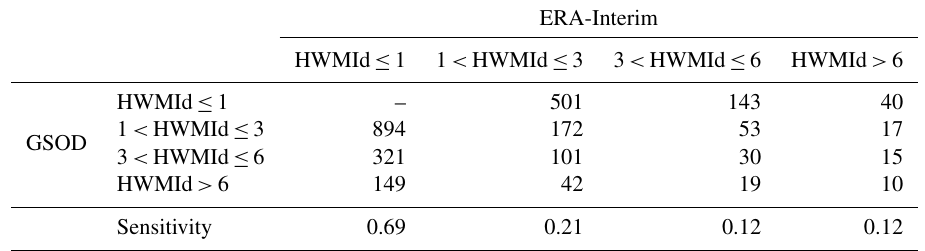
Table 1. Confusion matrix of heat wave detection from observation (GSOD) and reanalysis (ERA-Interim) for maximum temperature for the period 1981–2015.